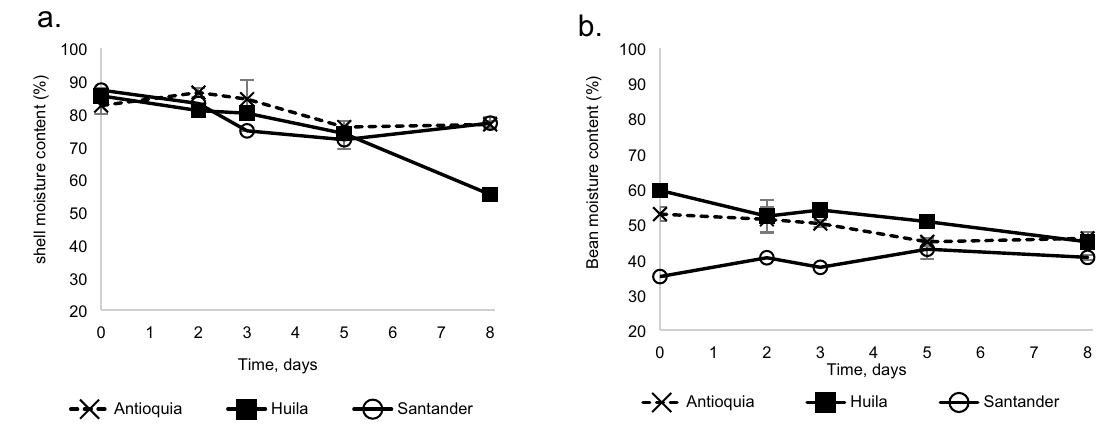
Figure 2. Moisture content of cocoa during fermentation carried out at three different locations: Antioquia, Huila, and Santander ( a ) shell and ( b )